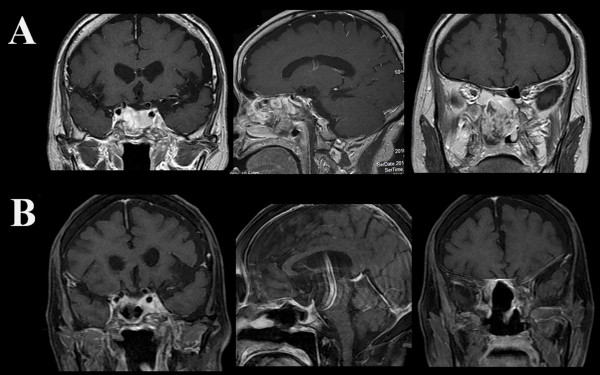
Recurrence of the tumor. A. Four months after the first surgery, MRI demonstrates rapid regrowth of the tumor filling sphenoid and ethmoid sinuses and nasal cavity. B. A residual tumor is seen in the cavernous sinuses after massive tumor resection.